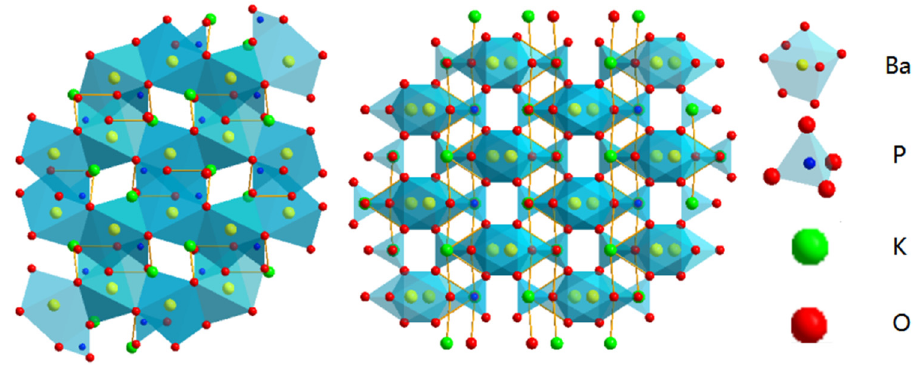
Figure 3: The structure fragments of KBaPO 4 .